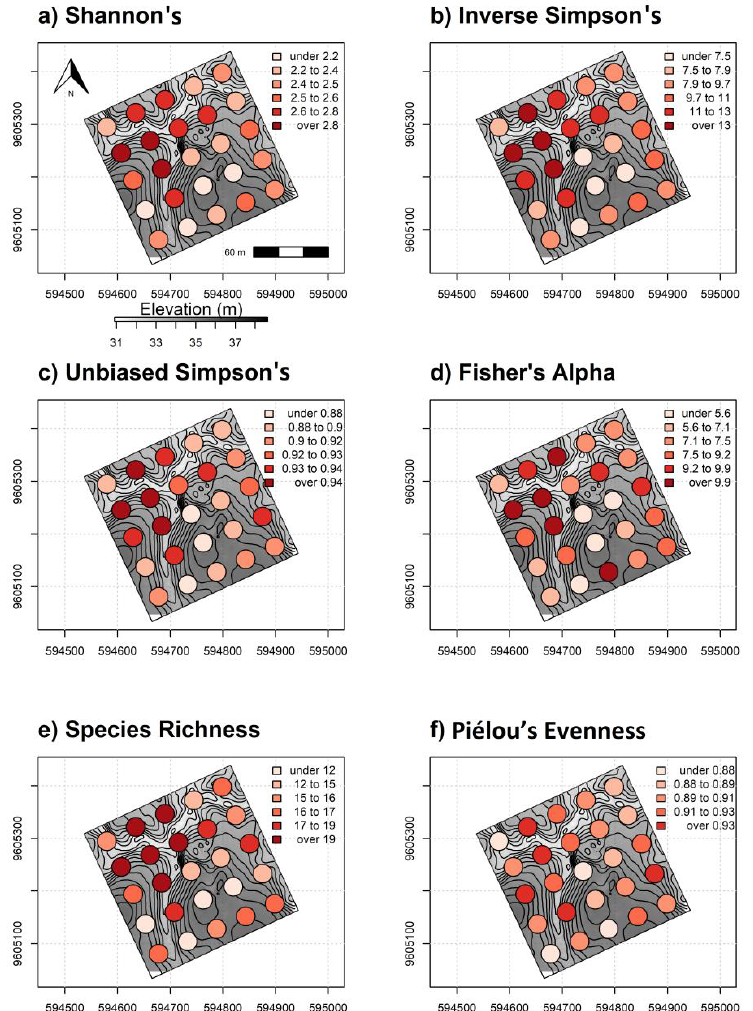
Figure 12. Regularly spaced 0.10 ha validation plots colored by α-diversity values ( a ) Shannon’s H′, ( b ) inverse Simpson’s, ( c ) unbiased Simpson’s, ( d ) Fisher’s alpha, ( e ) species richness and ( f ) Piélou’s J (evenness) overlaying elevation data and 3 m contours. High to low elevation is represented by dark gray to lighter background colors, respectively.